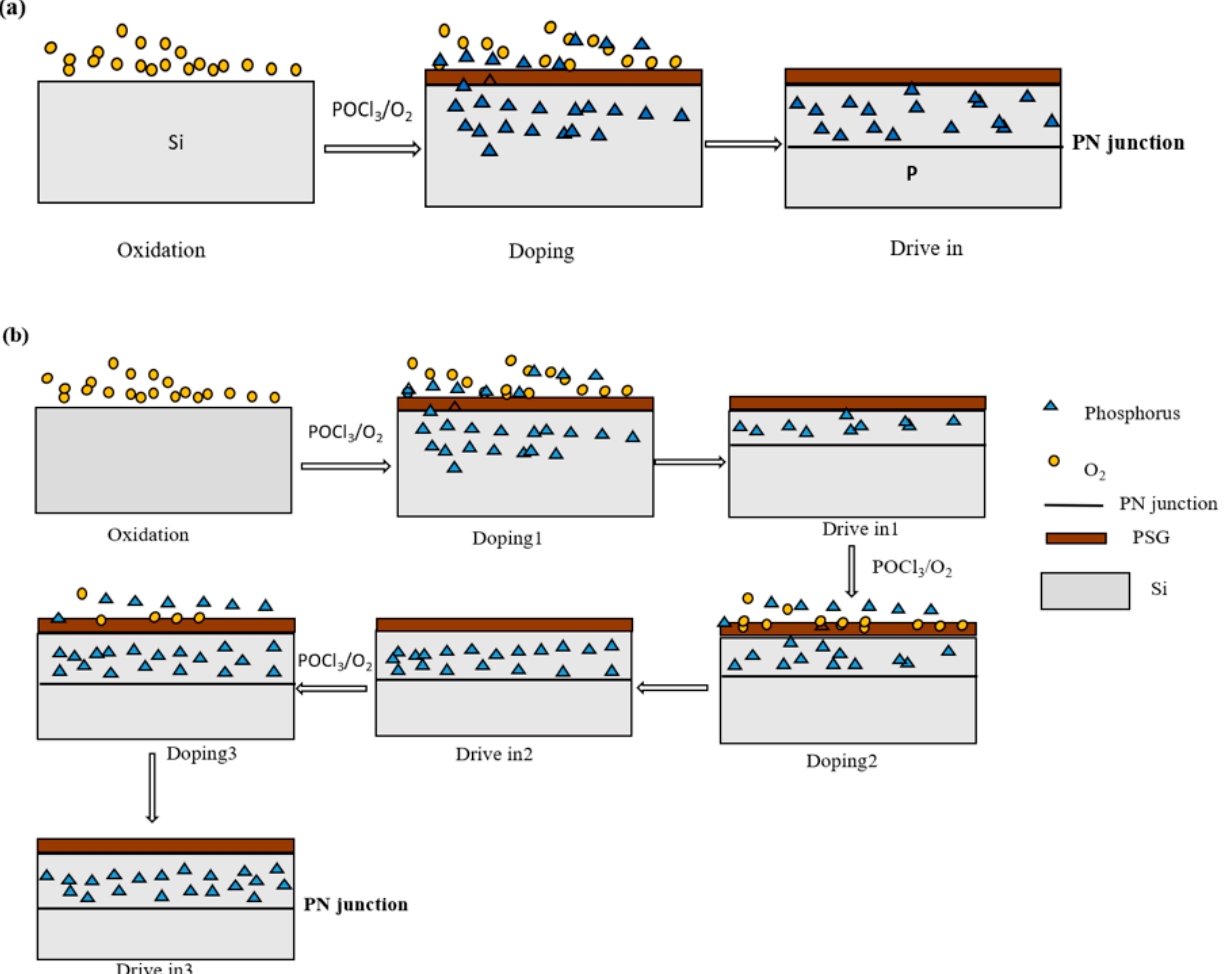
Figure 2. Schematic diagrams of the PN junction of solar cells obtained from ( a ) BKM and ( b ) LHL diffusion processes.